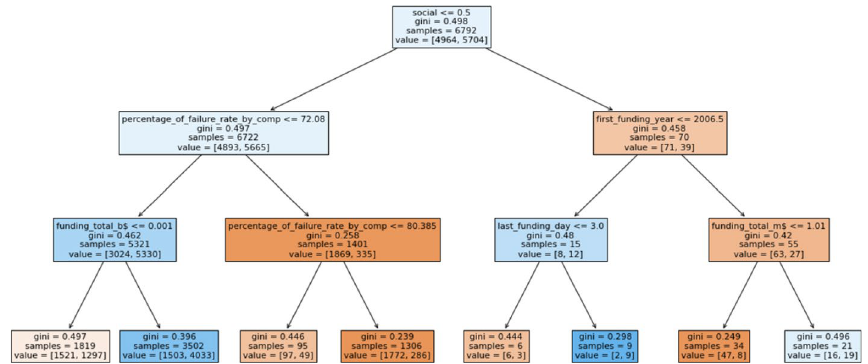
Fig. 15 An example of a decision tree from Random Forest learned from proposed IBM